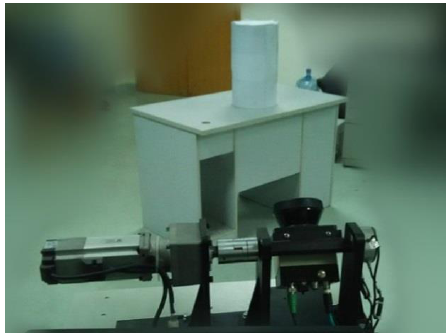
Figure 8. Experimental setup.